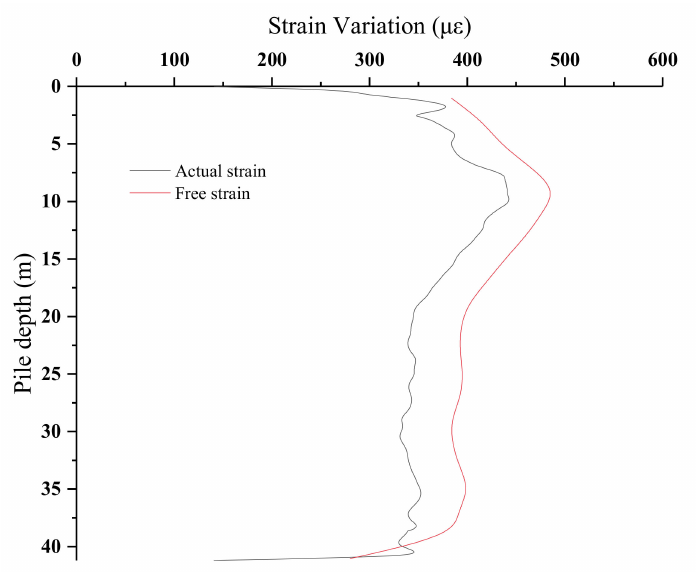
Figure 9. The last test tested the strain with the calculated free